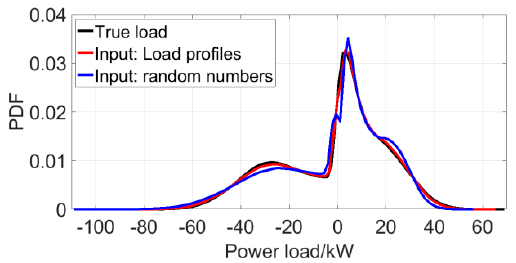
Energies 2019 , 01 , x FOR PEER REVIEW 13 of 16 Figure 12. Probability density function of BEV_DR. Figure 12. Probability density function of BEV_DR. Figure 12. Probability density function of BEV_DR.